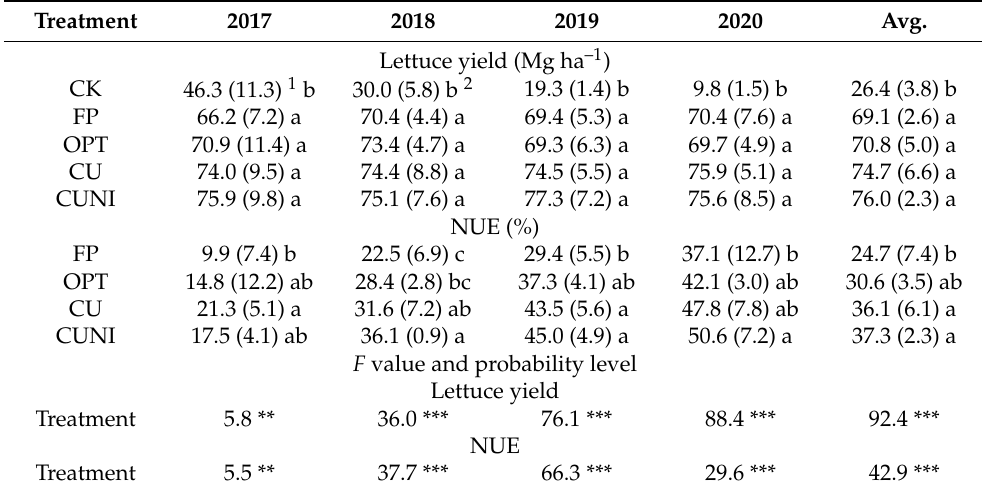
Table 1. Lettuce yield and N use efficiency (NUE) under different treatments during 2017–2020.